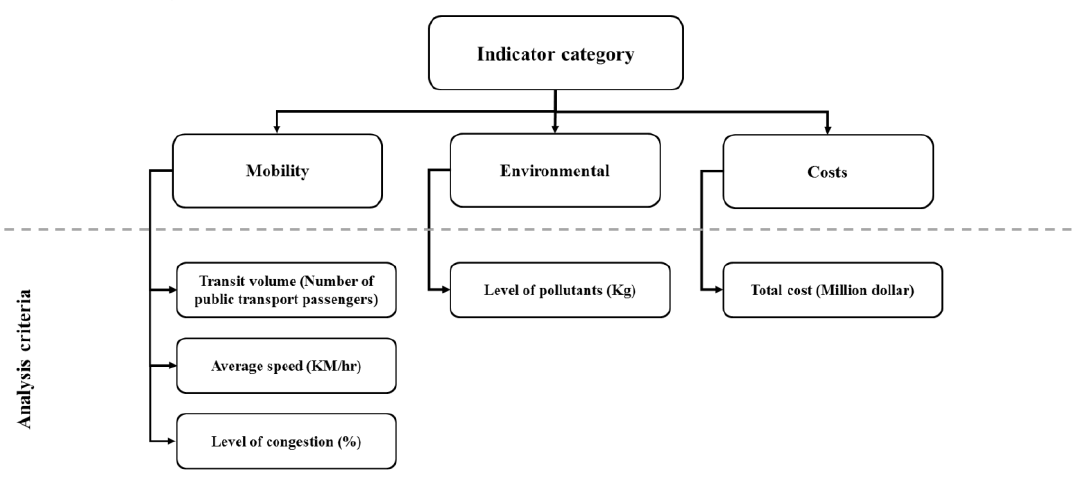
Figure 5: Indicators and their criteria to evaluate